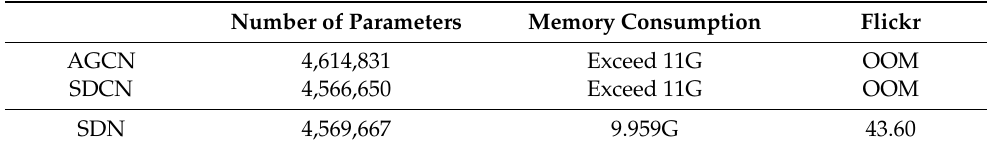
Table 4. Accuracy of graph clustering on Flickr. “OOM” means “out of memory”. Number of